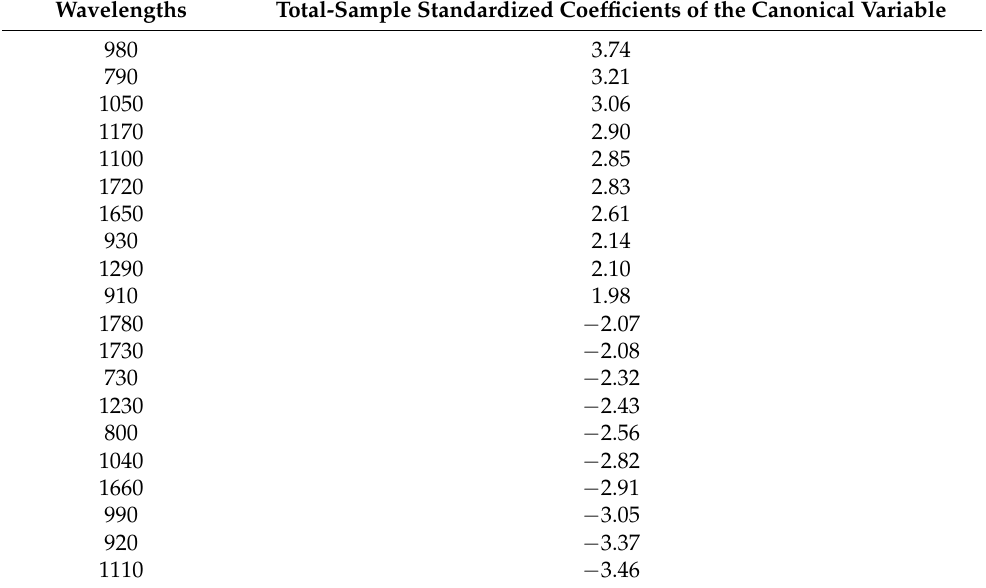
Table 4. Estimates of total-sample standardized coefficients of the canonical variable.